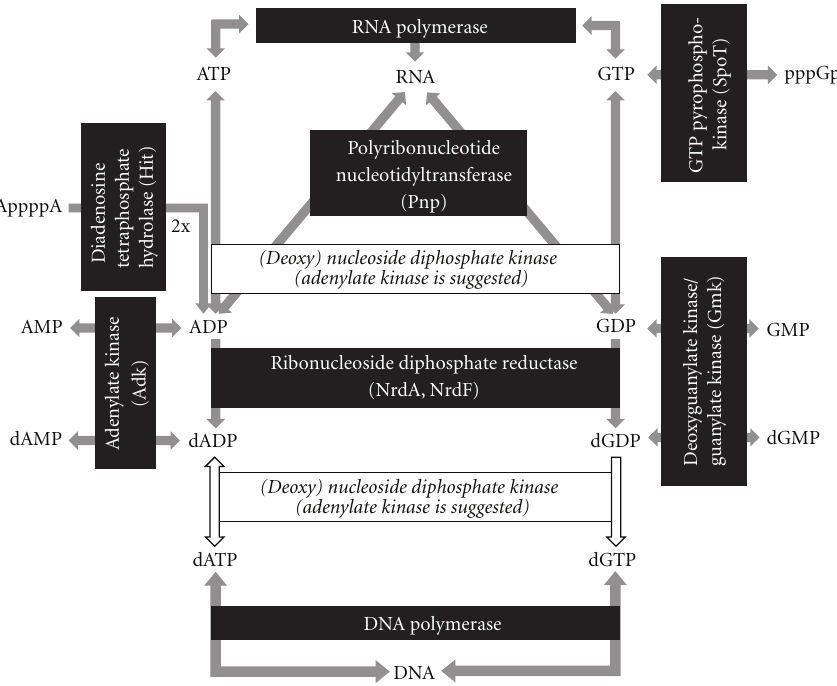
Figure 11: Principle of purine metabolism in